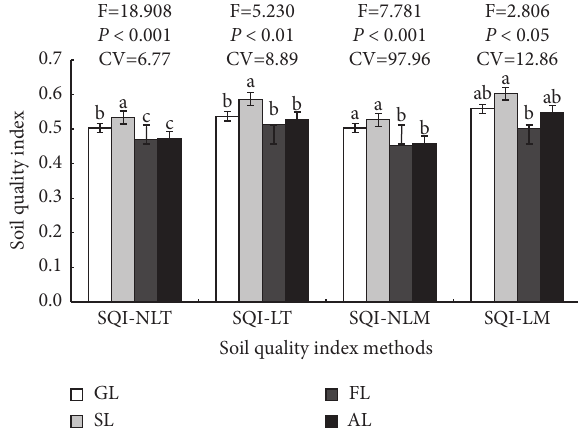
Figure 1: The indexes of soil quality constructed among different types of land use are compared. The different lowercase letters denote substantially important types of land use at P < 0 . 05. Standard errors are denoted by the bar graphs. GL, grassland; SL, shrubland; FL, forestland; AL, abandoned land; SQI-LT, linear scoring-TDS; SQI-LM, linear scoring-MDS; SQI-NLT, nonlinear scoring-TDS; SQI-NLM, nonlinear